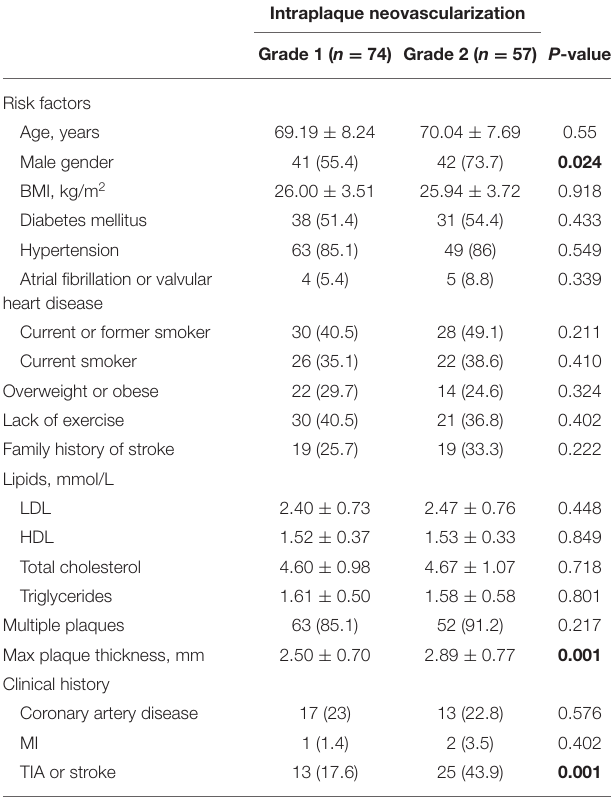
TABLE 3 | Intraplaque neovascularization on SMI and its association with clinical characteristics. Intraplaque neovascularization